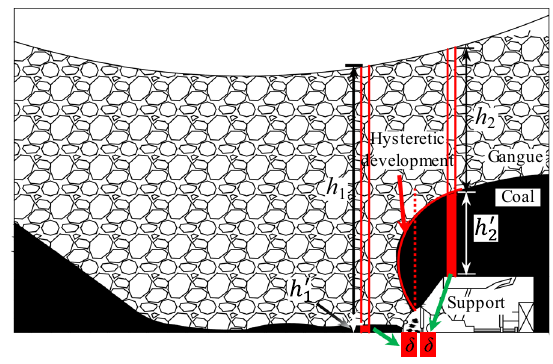
Fig. 4 Schematic diagram of gangue-coal columns in a normal